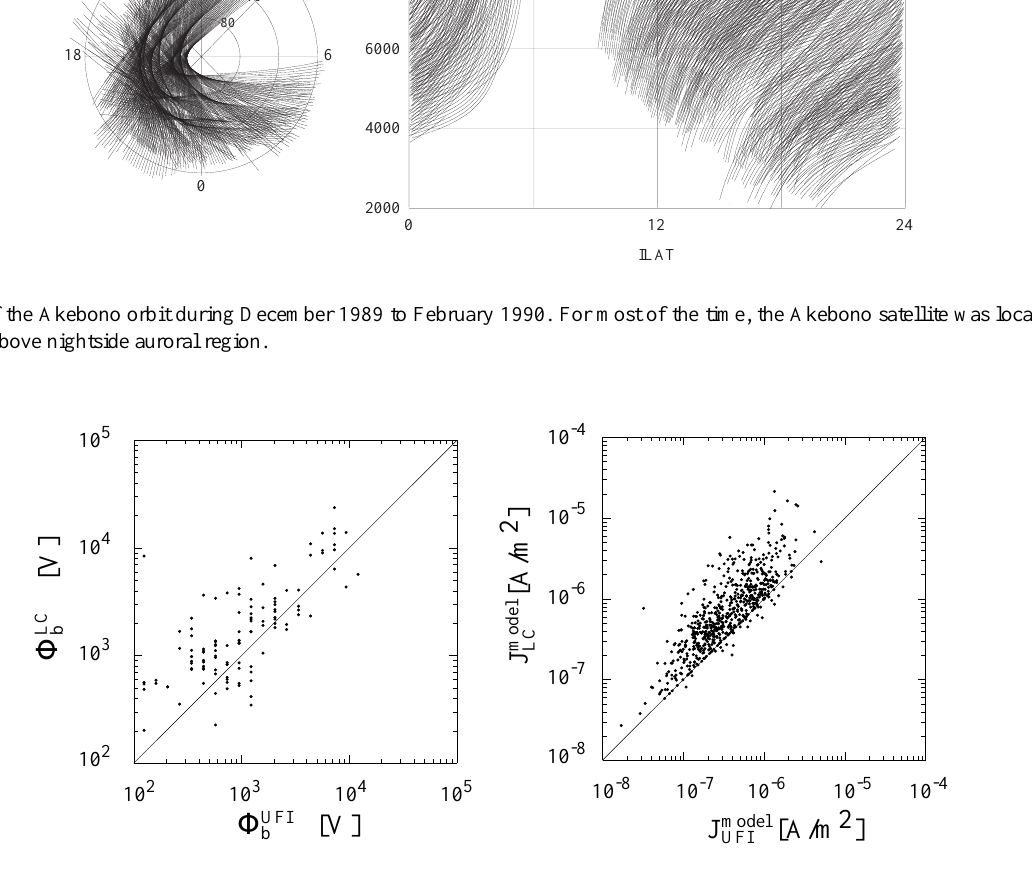
and J model LC UFI